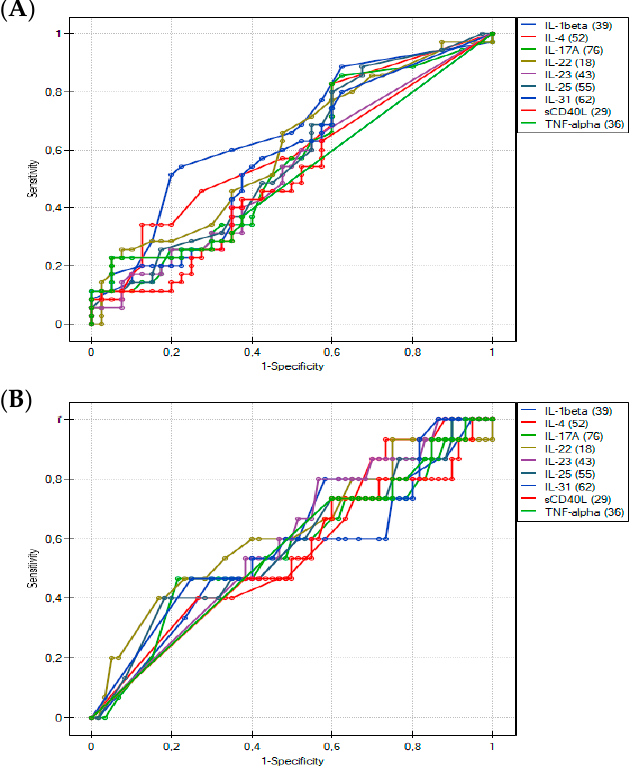
Figure 4. Univariate receiver operating characteristic (ROC) curves show a correlation between the serum concentrations of nine cytokines ( A ) in patients with IgE-mediated allergy and other participants; ( B ) in patients with delayed-type food allergy and other participants. Table 5. The discriminant value of serum expression in all examined cytokines showing significant p -values and the area under the receiver operating characteristic (ROC) curve (AUC) between studied groups (the IgE- mediated FA group (1) vs. the control group (0)). The statistically significant value is in bold and underlined